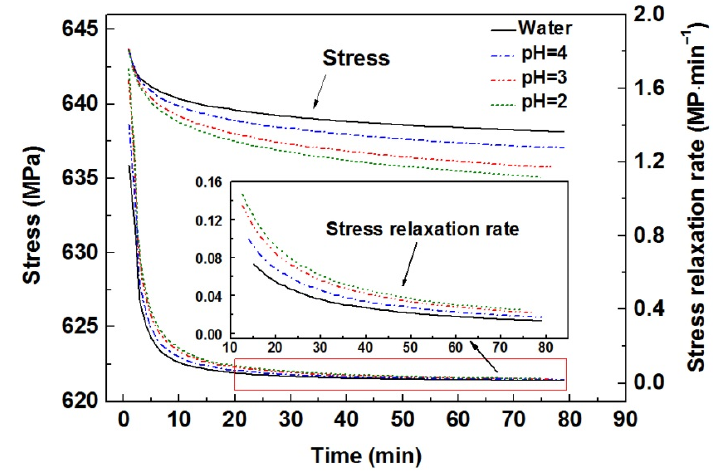
Figure 2. The variations of stress and relaxation rate versus time for samples immersed in water and H 2 SO 4 solutions with pH 4, 3, and 2, respectively, during relaxation.